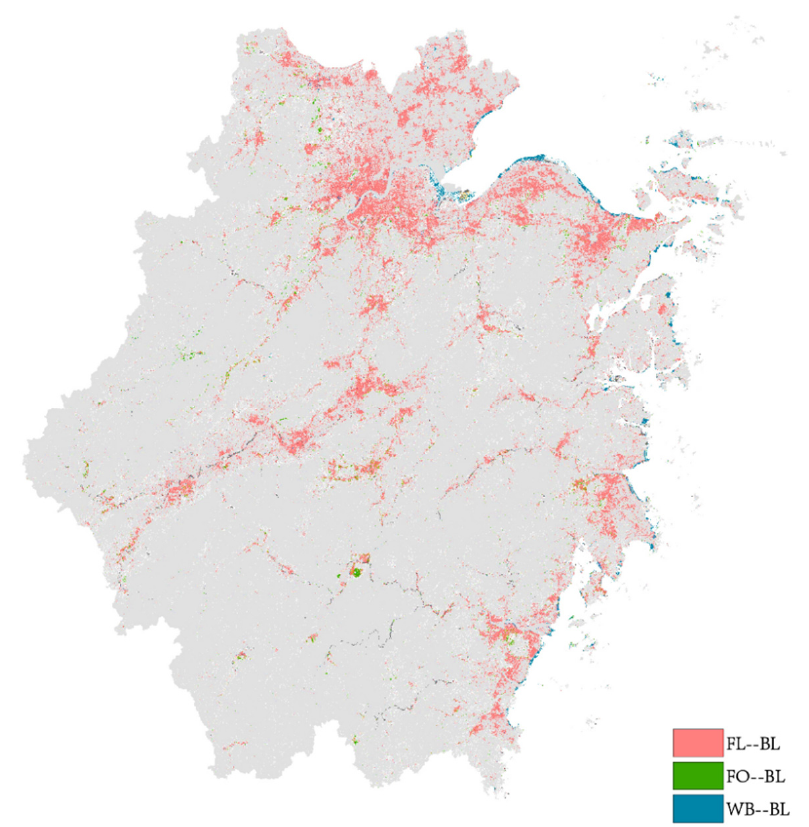
Figure 5. Spatial mapping of the transformation of agricultural areas, forestland, and water bodies into built ‐ up areas from 1990 to 2020.